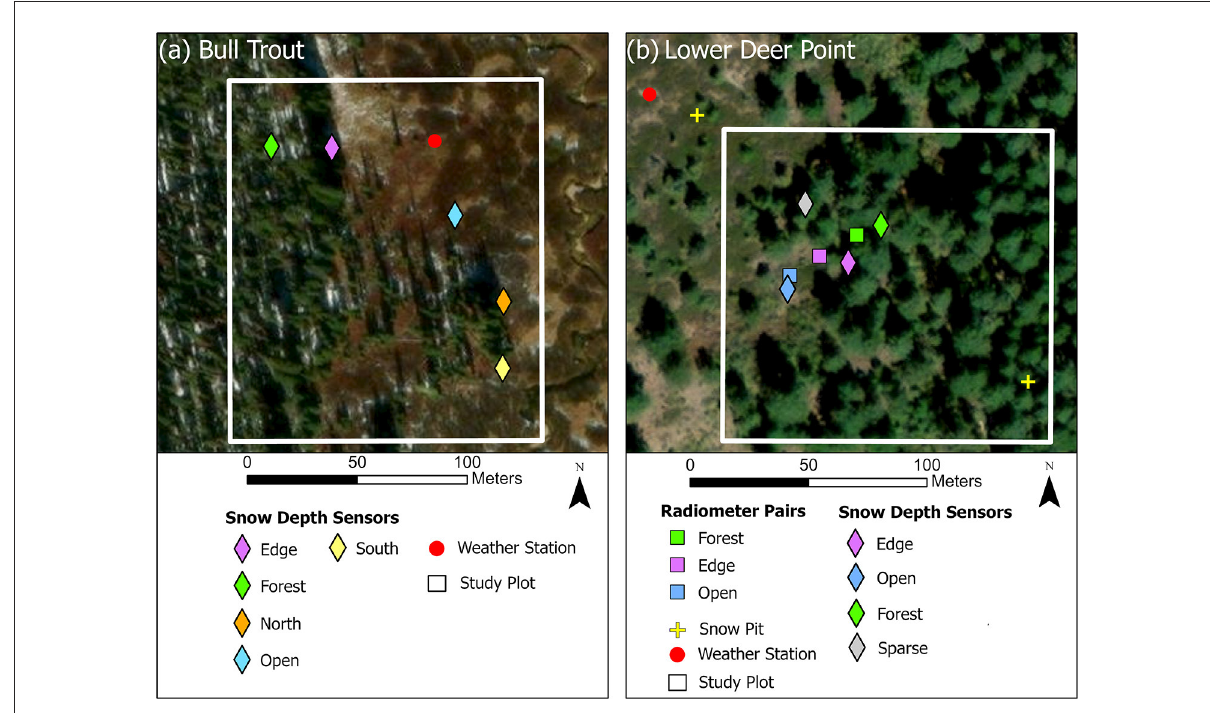
FIGURE2 Locations with aerial images (ESRI, 2017) of sensors at the Bull Trout study location (a) and Lower Deer Point study location (b) . The white squares correspond to the white squares in Figure